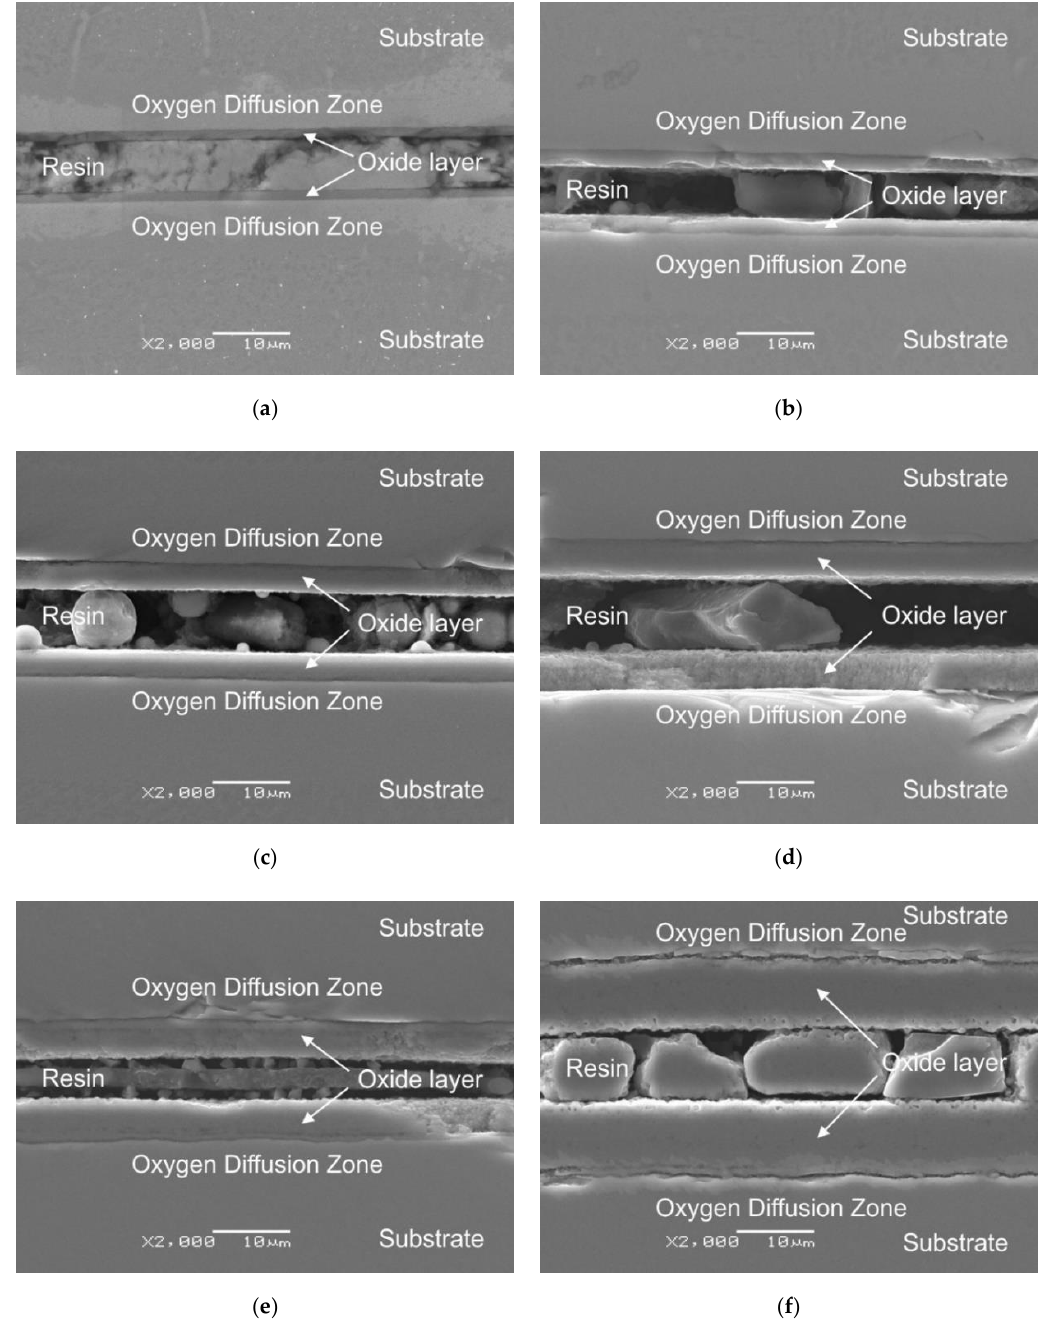
Figure 7. Oxide scale on a cross-section of titanium Grade 2, formed at 600 °C (( a )—4 cycle/24h, ( b )—12 cycle/72 h), 650 °C (( c )—4 cycle/24h, ( d )—12 cycle/72h) and 700 °C (( e )—4 cycle/24h, ( f )—12 cycle/72 h).